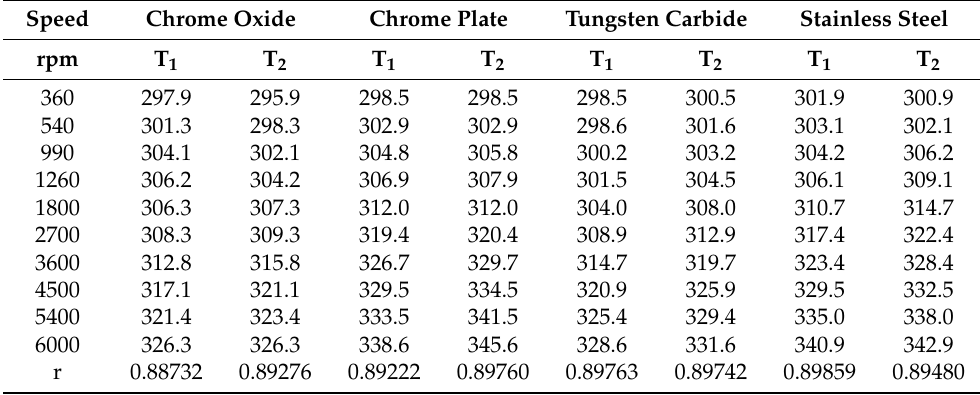
Table 4. Contact temperatures at the sealing interface for Test 1 (T 1 ) and Test 2 (T 2 ), reflecting repeat experiments conducted on the 12 oz seal spring against all sleeves. Calculation of Pearson Coefficient ‘r’ for statistical validity and reproducibility of